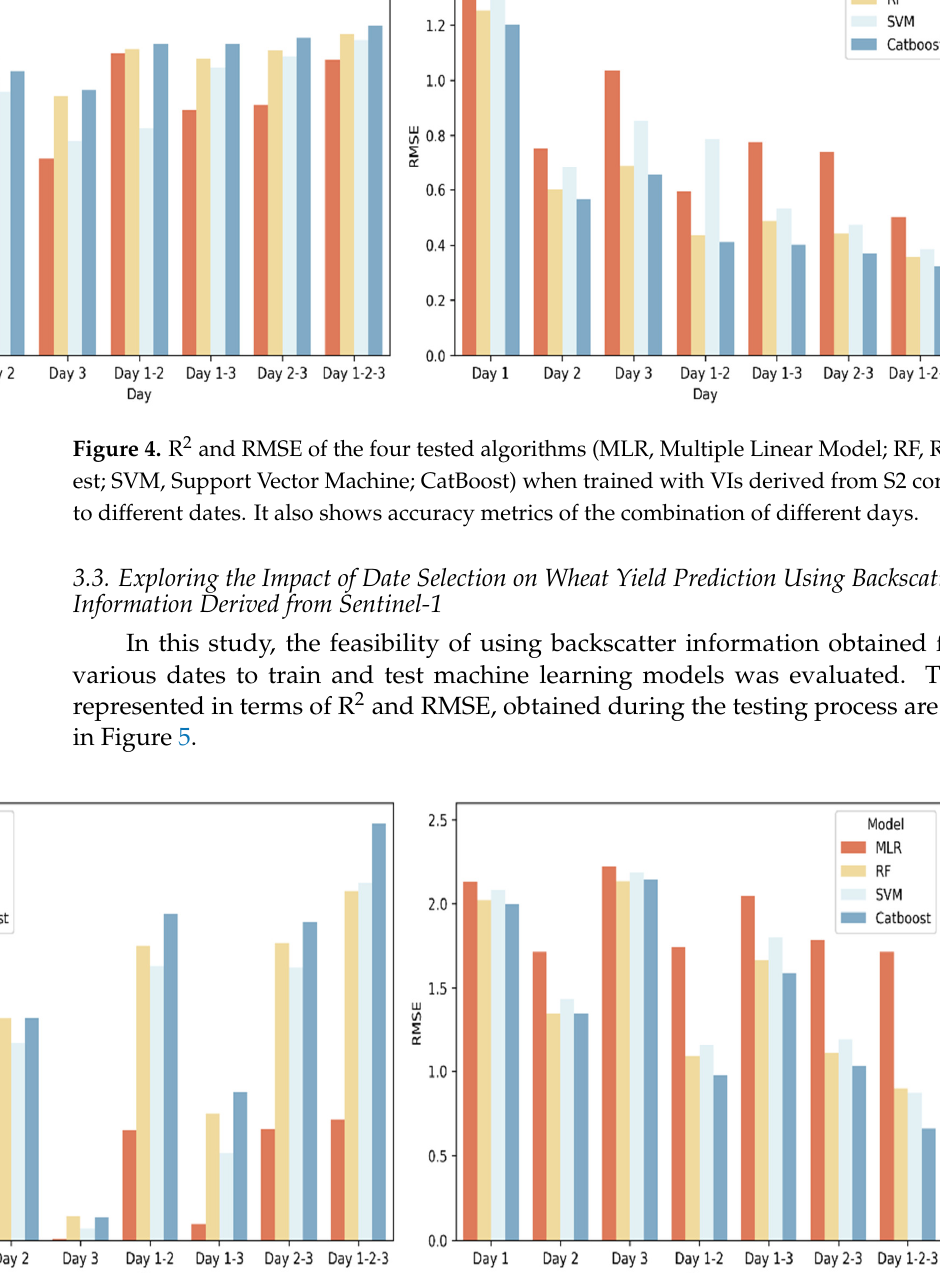
CatBoost algorithm to 0.77 for MLR, while RMSE ranged from 0.32 for CatBoost to 0.50 for MLR.